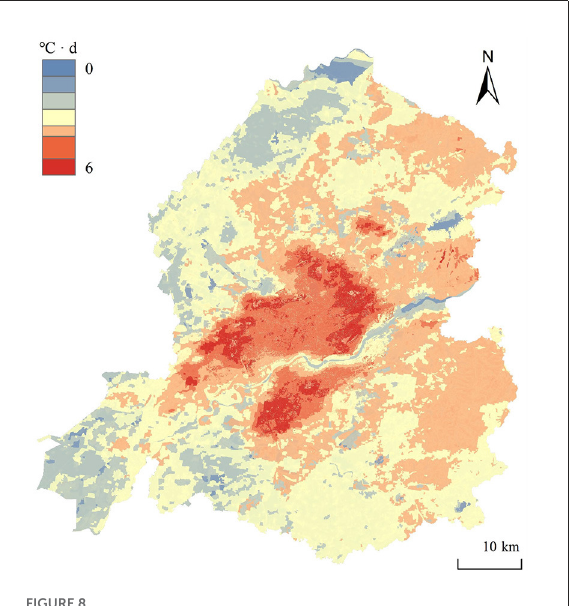
FIGURE8 CDD of study area. CDD, cooling